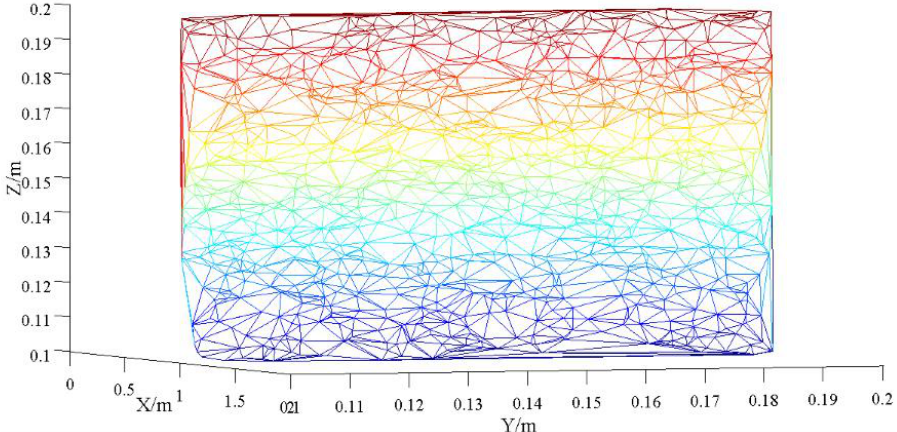
Figure 2. Triangulation of the original point.